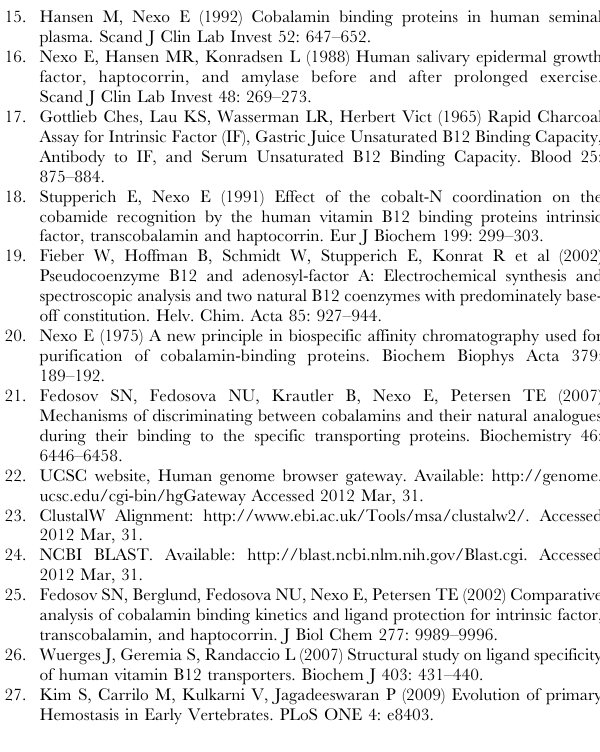
Table S1 List of TC, HC, and IF-like nucleotide sequences found in registered vertebrates by NCBI and UCSC